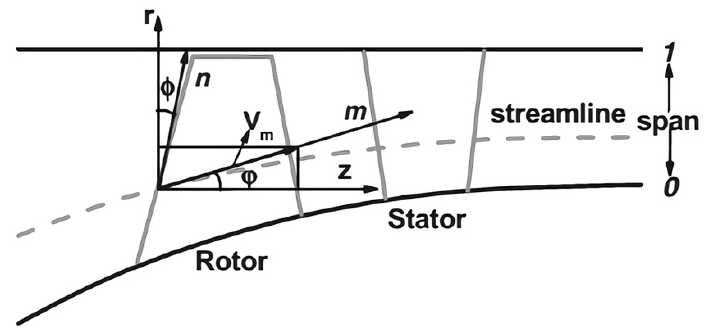
Figure 11. Schematic of computation domain.